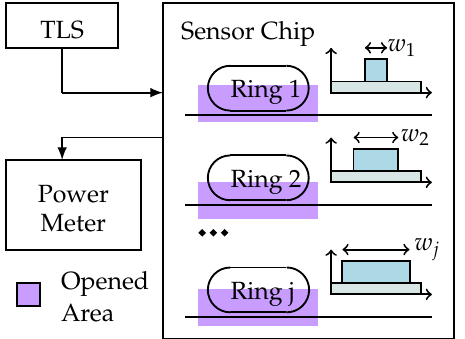
Figure 1. Sketch of the measurement system with the sensor chip. A tunable laser source (TLS) is used to sweep through the desired wavelength range; a power meter records the transmission spectrum. On the sensor chips, j individual ring resonators coupled to access waveguides are used for the measurements. In our realization, the sensor chip was covered by a protective SiO 2 layer. This protective layer was etched away for half of the area of the ring resonator (marked in purple). Only this area was accessible to the sample